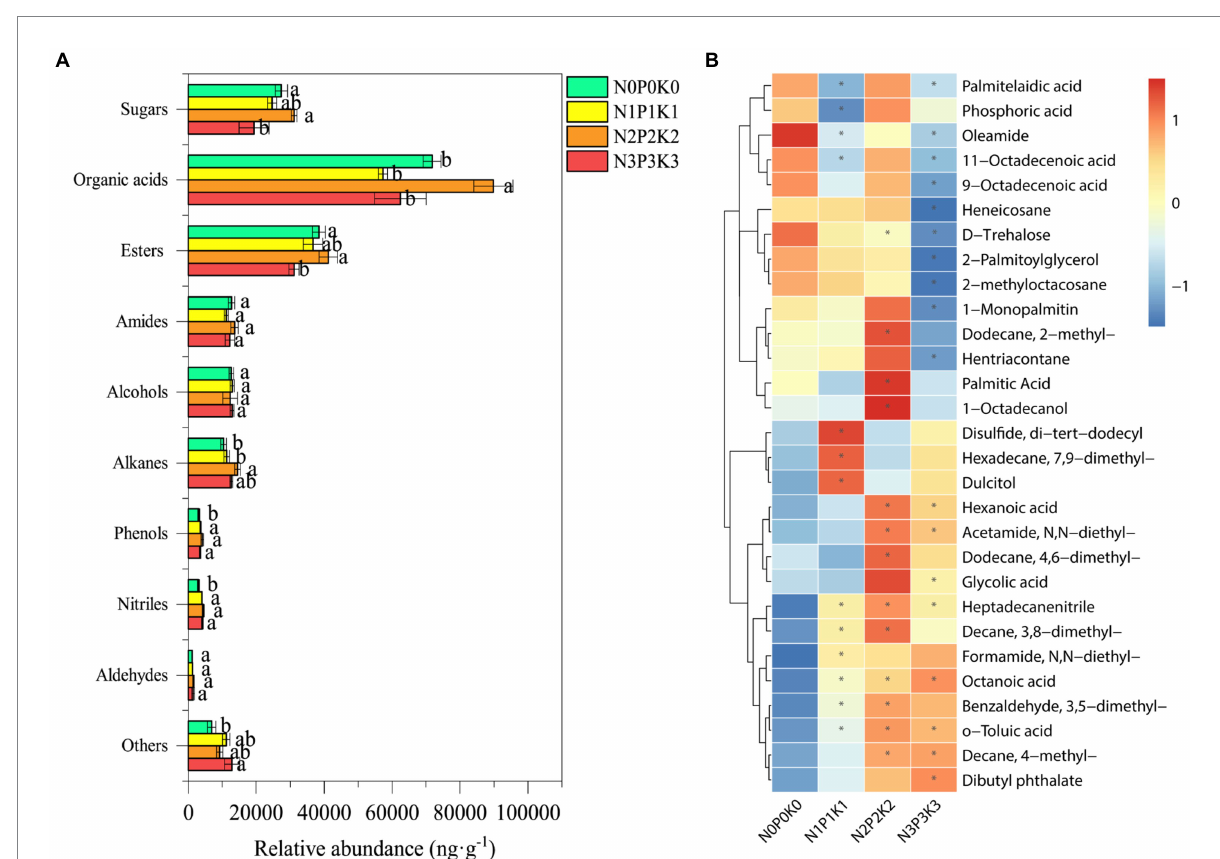
FIGURE 5 (A) Relative abundance of classified metabolites under different fertilization levels. Values are means ± SEM ( n = 5). Different letters above the bars indicate statistically significant differences at p < 0.05. (B) Heatmap of differential metabolites under different fertilization levels, reddish color indicates increased metabolites content while bluish color indicates decreased metabolites content, * represent differential metabolites for three fertilization treatments compared to no-fertilization (VIP > 1 and p <